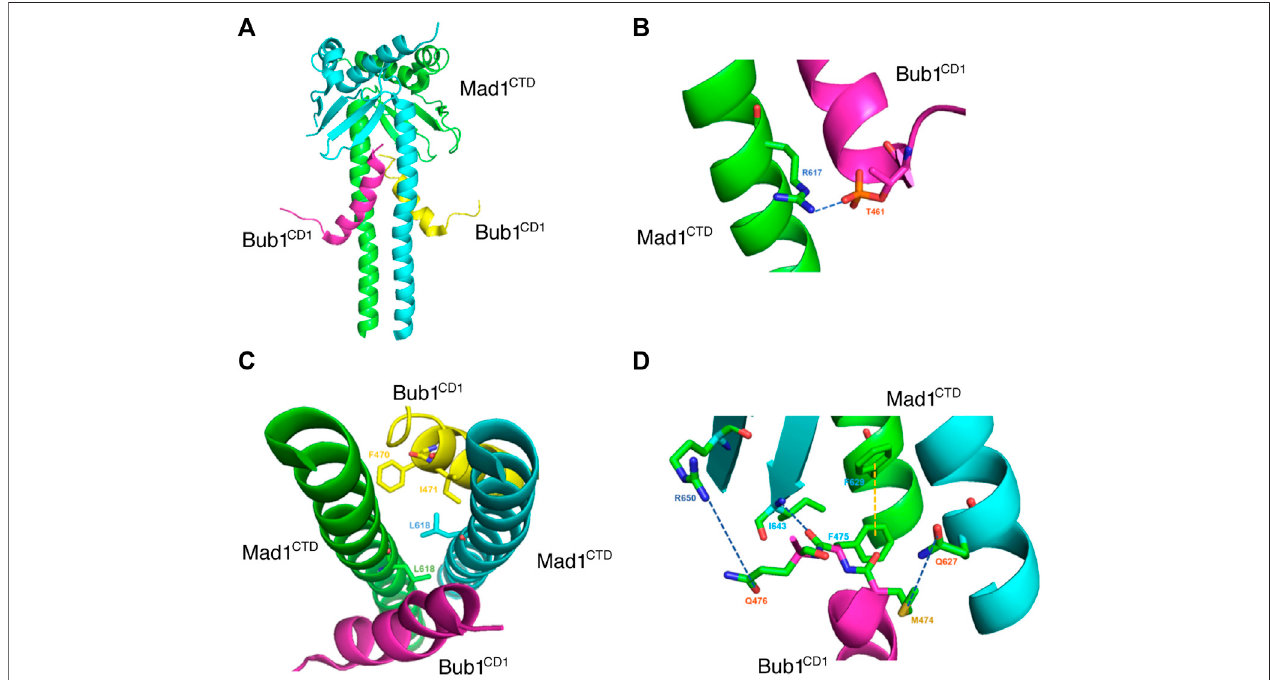
FIGURE 2 | Crystal structure of Mad1CTD-Bub1CD1 shows multiple direct interactions. (A) Crystal structure of Mad1CTD dimer (green/light blue) bound to two Bub1CD1 molecules (purple/yellow) from PDB: 7B1F (Fischer et al., 2021). (B) Close-up view of the interaction between Mad1 R617 with Bub1 pT461. The dark blue dashes indicate the hydrogen bonding. (C) Top view of the hydrophobic pocket formed by Mad1 L618 and Bub1 F470 and I471. (D) Close-up view of the interactions between Mad1 R650 and Bub1 Q476, Mad1 I643 and Bub1 F475, Mad1 F629 and Bub1 F475, Mad1 Q627 and Bub1 M474. The dark blue dashes indicate hydrogen bonding and the yellow dashes indicate π – π stacking. Pymol was used to visualize the structure and interactions between residues.